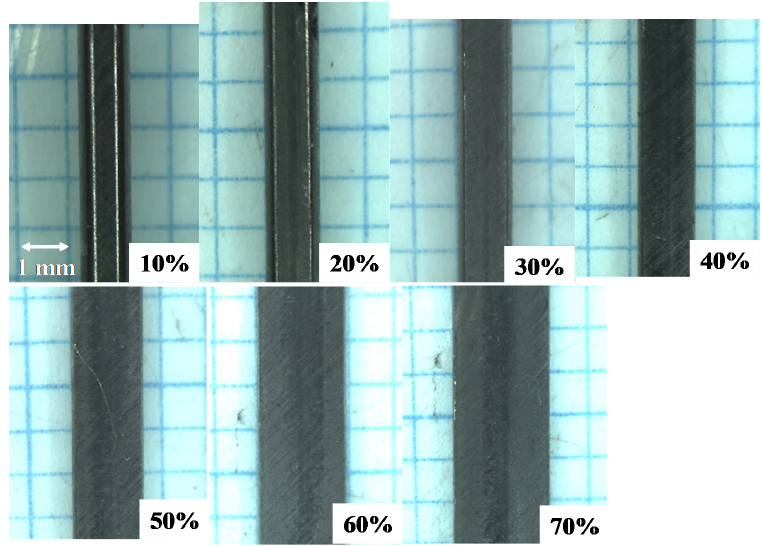
Figure 5. Variation of contact interface area in flattening into a plate with increasing the reduction in diameter.